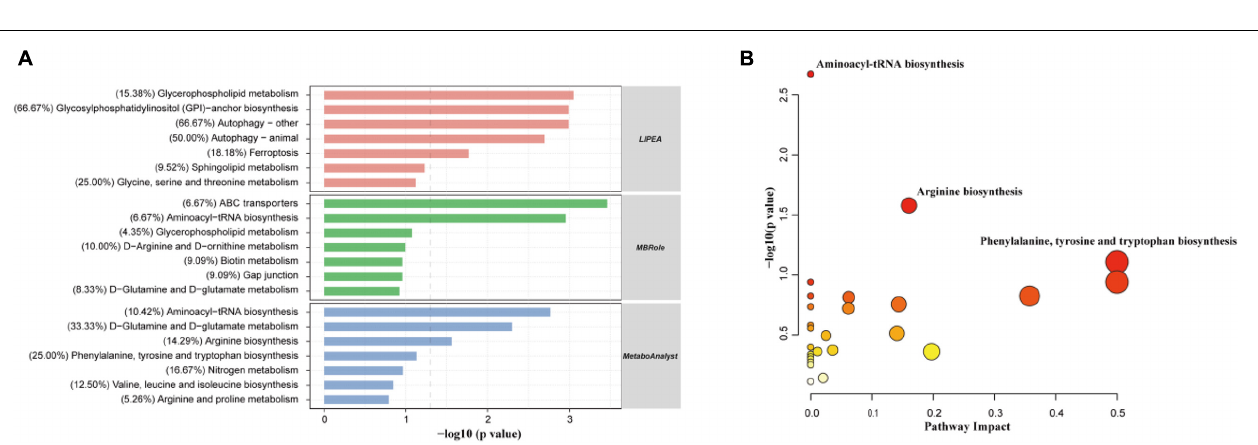
FIGURE 6 | Differential metabolites were significantly enriched in multiple pathways, suggesting that the addition of CE remarkably perturbed gut metabolic activities ( n = 6 hens/group). (A) Functional KEGG pathway enrichment analysis of the differential expressed metabolites was carried out through three different platforms (LIPEA, MBRole, and MetaboAnalyst). (B) Analysis of metabolic pathways of DC and CE groups of differentially expressed metabolites was shown by bubble plot, each dot represents a metabolic pathway. X -axis and Y -axis stand for pathway impact and − log 10 ( P -value), respectively.